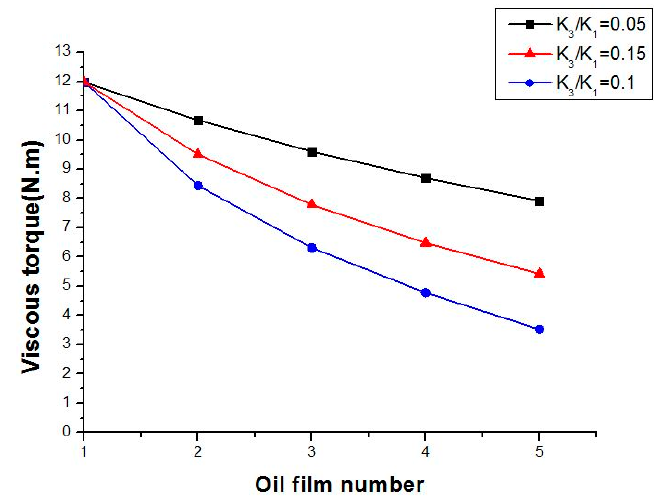
Figure 9. Viscous torque distribution with different K 3 / K 1 .